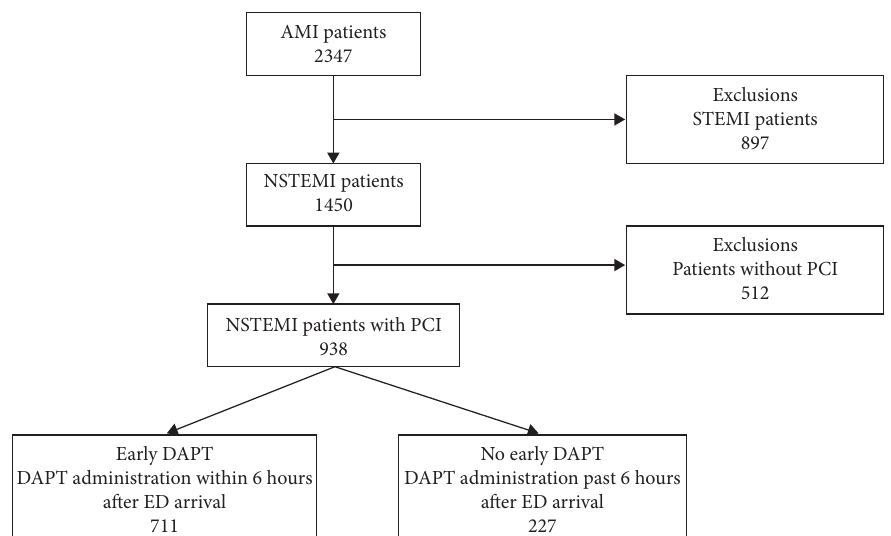
Figure 1: Flow chart of patient